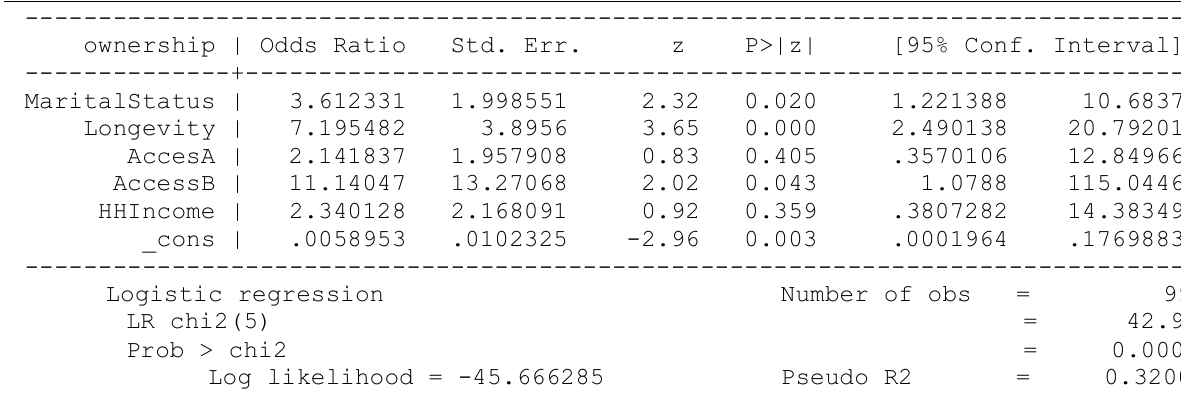
Table 4: Logistic regression results: odds ratios